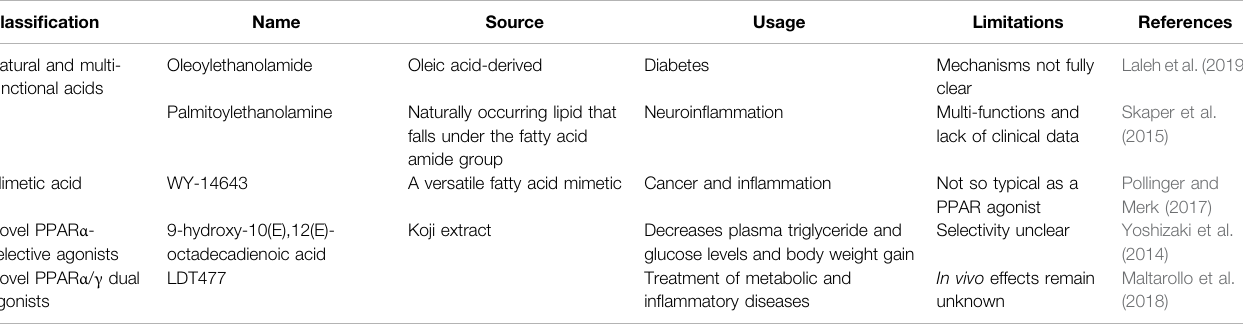
TABLE 3 | Representative agonists of PPAR- α